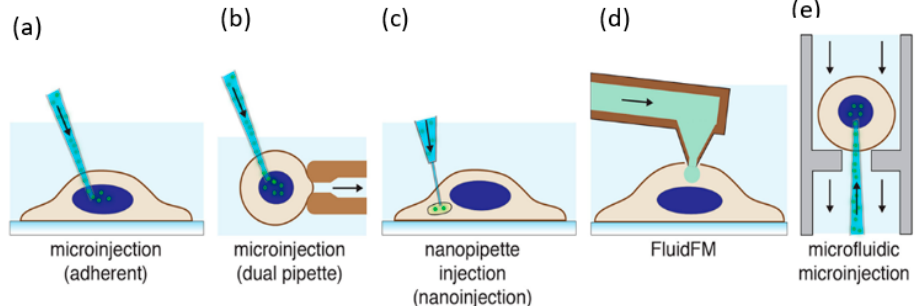
Figure 3. Microinjection for cell transfection. ( a ) Microinjection of an adherent cell using a glass micropipette [63]. ( b ) Microinjection of a suspended cell by a secondary holding pipette [67]. ( c ) Nanopipette injection of an intracellular organelle using a nanotube [68]. ( d ) Injection of cells using a hollow AFM cantilever (FluidFM) [66]. ( e ) Microfluidic microinjection in which a cell is pushed onto a sharp micropipette [61]. Reprinted with permission from ref. [43]. Copyright © 2018 American Chemical Society.